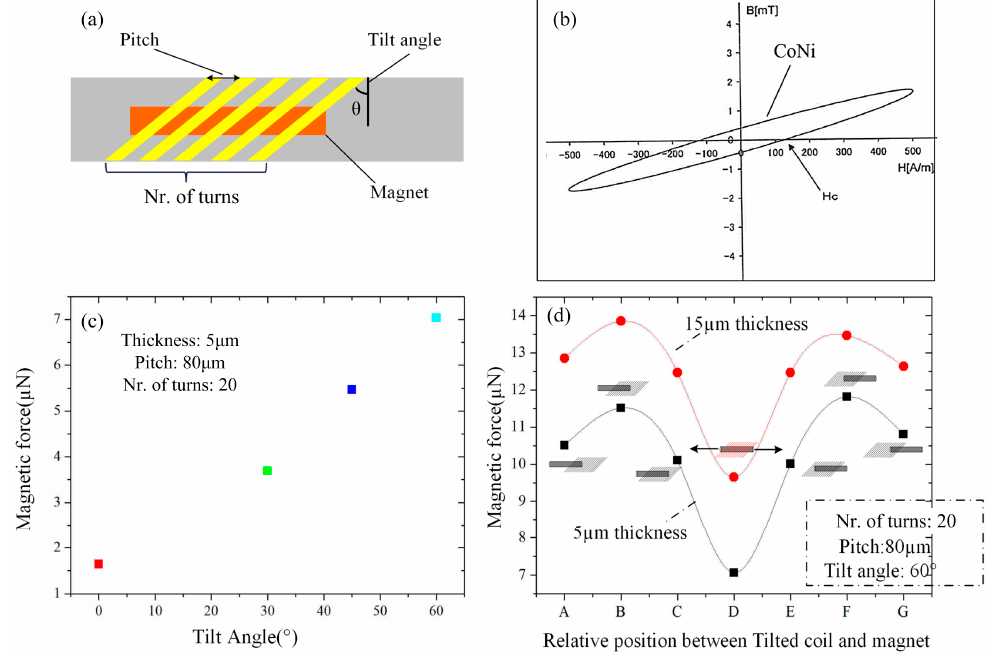
Figure 3. Parameters of designed microcoil and simulated results of magnetic force. ( a ) Key parameters of tilted microcoil and magnet; ( b ) B-H curve of CoNi magnet used; ( c ) Simulated magnetic force with different tilt-angles; ( d ) Simulated magnetic forces with relative positions between coil and magnet. (Nr. means number in the figure).